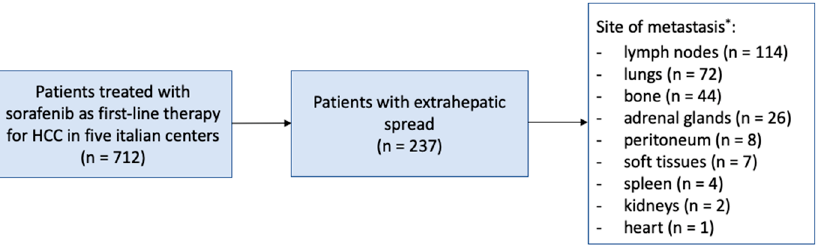
Figure 1. Study population and metastases localization distribution. * Multiple concomitant sites of metastases were recorded in 48 patients. Table 1. Baseline characteristics of patients with extrahepatic spread (EHS) compared with all re- maining patients without extrahepatic spread (all w/o EHS). The latter is reported and also divided into two groups, which were themselves split in advanced HCC without metastases (BCLC-C w/o EHS) or intermediate HCC (BCLC-B). Table 2. Baseline characteristics of patients with lymph node, lung, bone and adrenal gland metastases compared with the rest of study